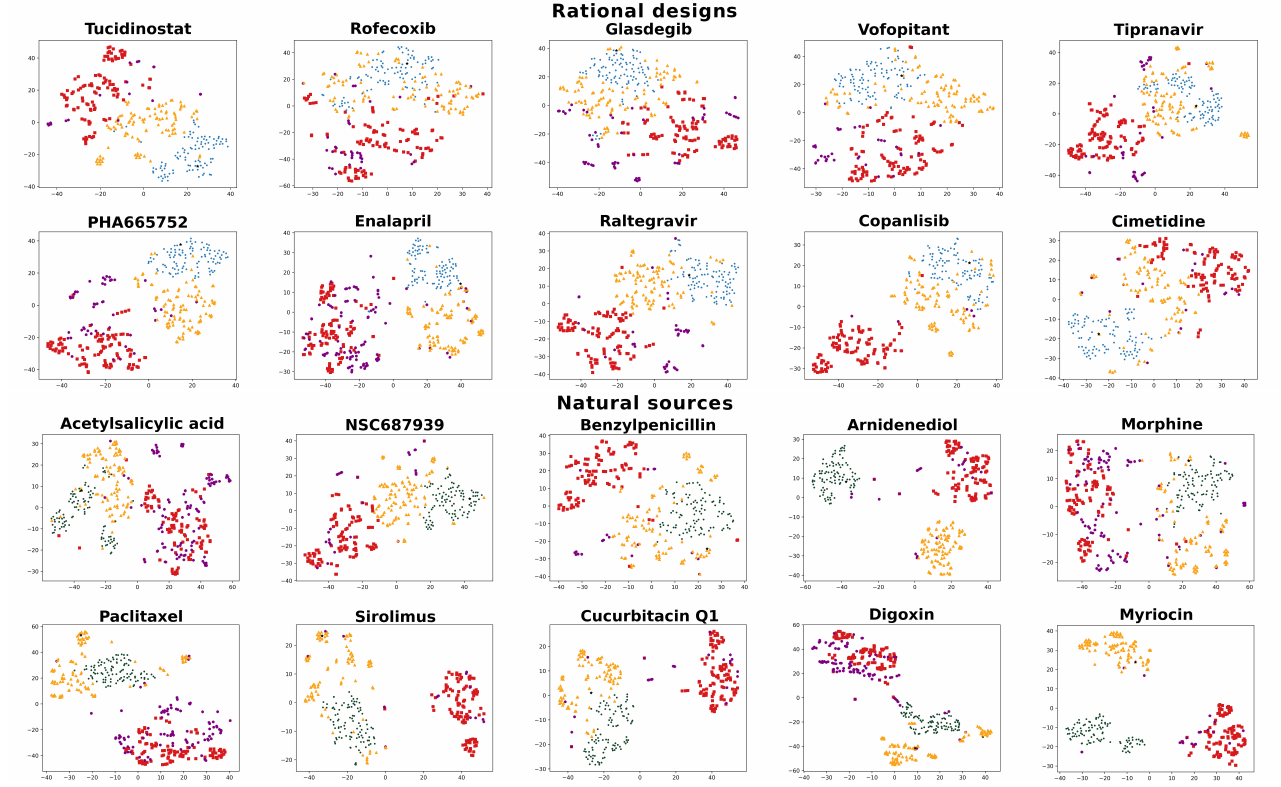
Figure 3. t-SNE visualizations for the interaction signatures of objective compounds, redesigns, and various controls with structural comparisons. t-SNE plots were generated for each of the twenty design objectives. The t-SNE algorithm was run on the interaction signatures of the objectives (black stars) and 100 redesigns (blue and green circles), as well as the 100 random (red squares), top 100 (orange triangles), and same indication (purple hexagons) control compounds. (Color coding is the same as in Figure 2.) Euclidean distances shown in t-SNE visualizations generally corroborate our findings from Figure 2 when considering the RMSD due to the maintenance of proximal points and distributions. The exceptions to this were for benzylpenicillin and paclitaxel, as Figure 2 shows greater proximity for designs than the top 100 control, whereas t-SNE plots show better clustering for the top 100 set around the objective. The generally (14/20) greater proximity of designed compound clusters to the objective point when compared to top 100, same indication, and random control compounds corroborate the behavioral similarity of designed compounds to their objective in the predicted interaction space, i.e., designed compounds are predicted to behave in the manner in which they were